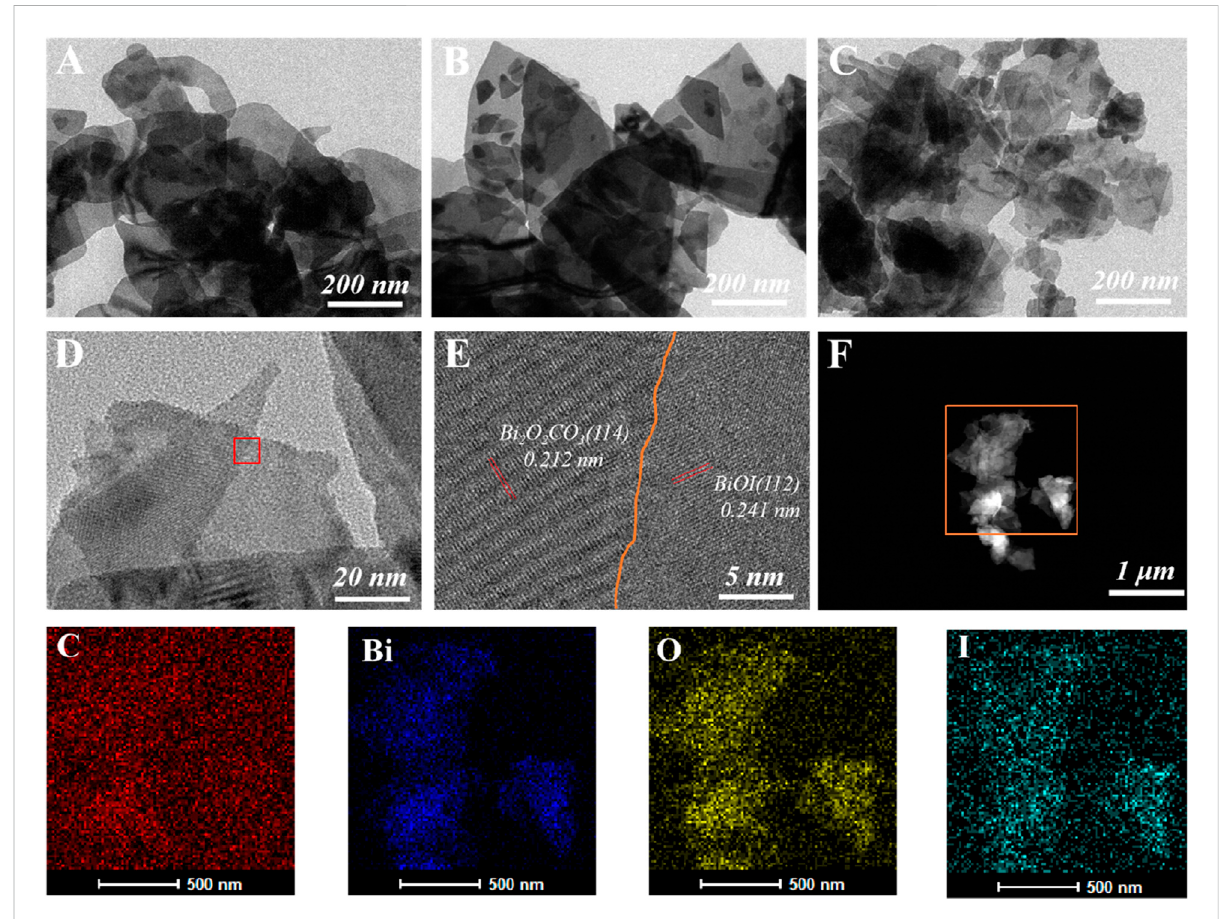
TEM images of (A) BOC, (B) BOI and (C) BOC/BOI-0.5; (D,E) high resolution transmission electron micrographs of BOC/BOI-0.5, and (F) STEM and element mapping